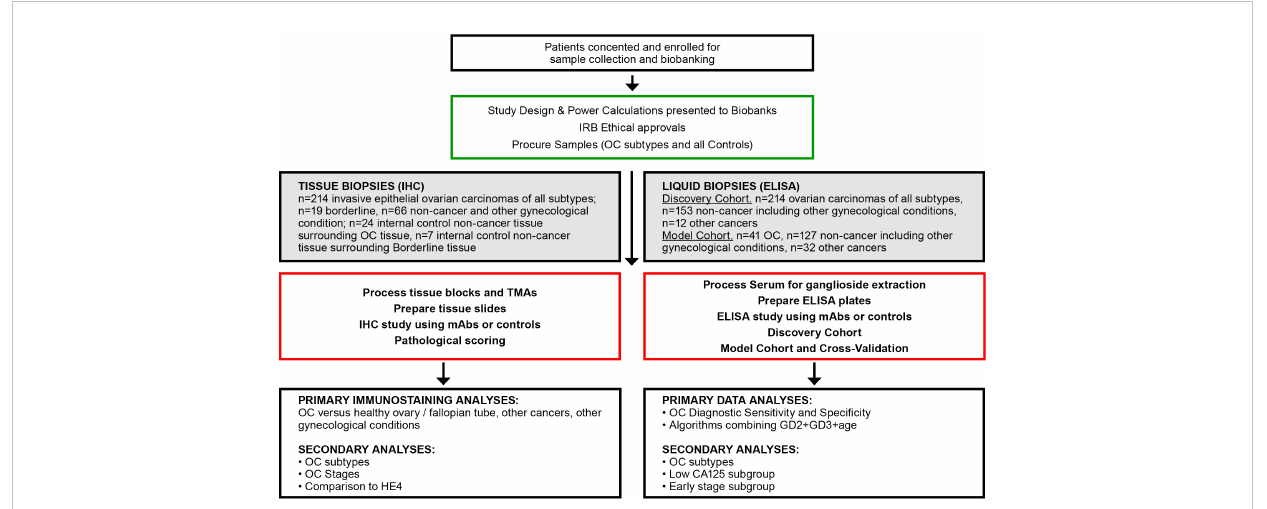
FIGURE 1 Flowchart of experimental approaches and analyses. OC, ovarian cancer; IHC, immunohistochemistry; TMA, tissue microarray; mAb, monoclonal antibody; ELISA, enzyme linked immunosorbent